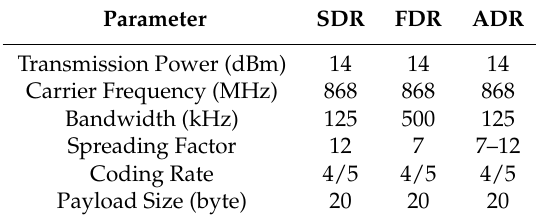
Table 1. Long-range radio (LoRa)WAN configurations for different data-rate